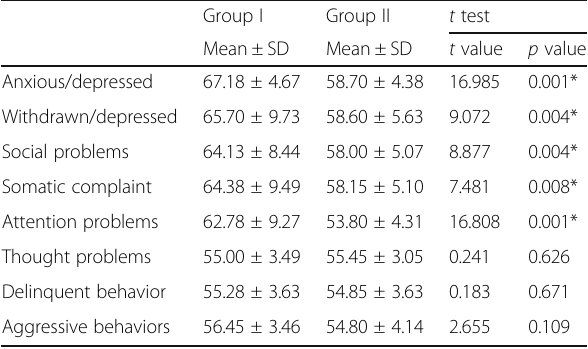
Table 1 Statistical analysis of the Child Behavior